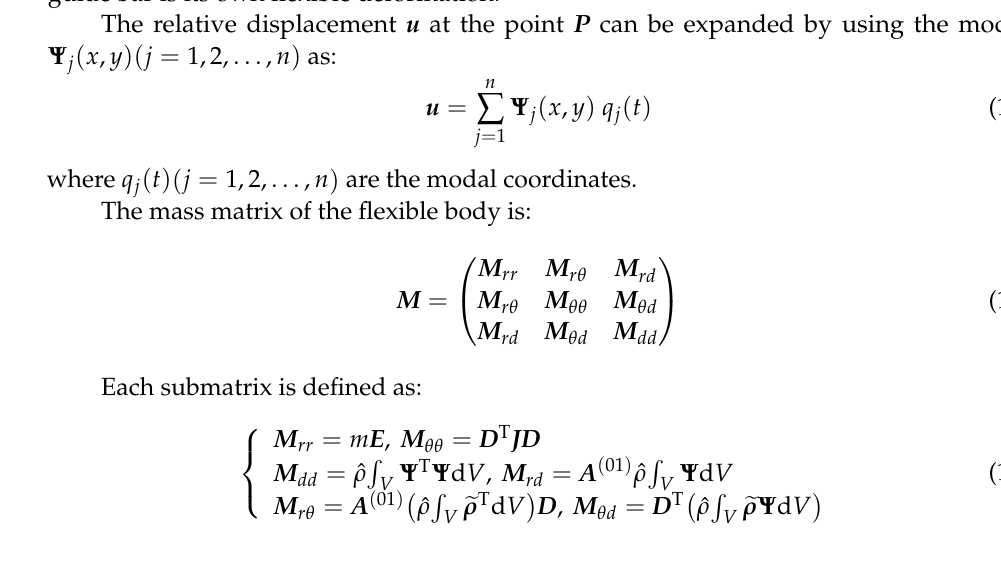
Figure 6. Floating coordinate system of the flexible guide bars. The floating coordinate system of the flexible guide bar is established at the midpoint of the fixed constraint at the bottom end, and the bottom end of the guide bar is a fixed constraint, so it does not produce a wide range of rigid body motion. The motion of the guide bar is its own flexible